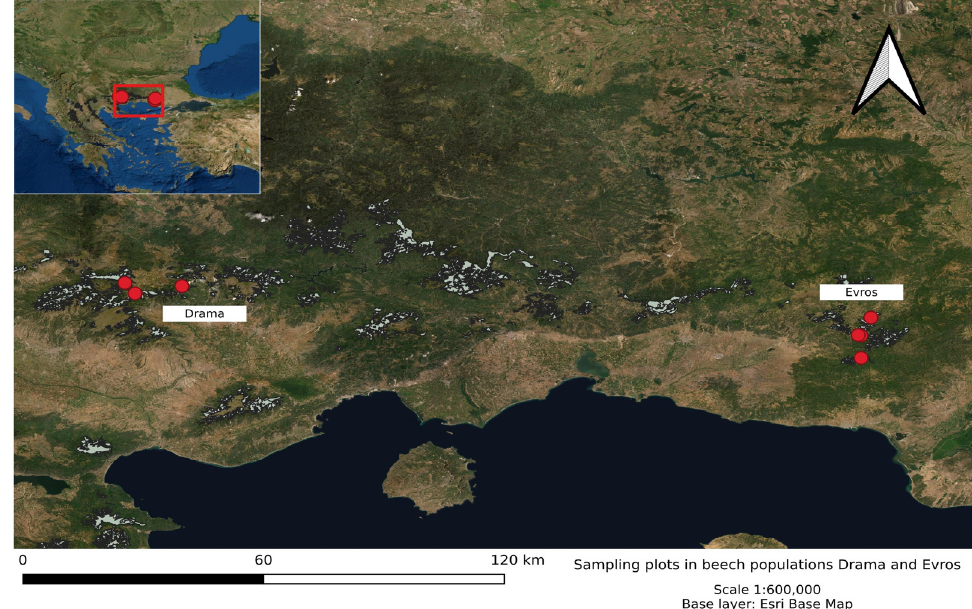
Figure 1. Map with the location of sampling plots in the beech populations Drama and Evros in NE Greece. Light-gray shading indicates the area covered by beech forests in Greece.